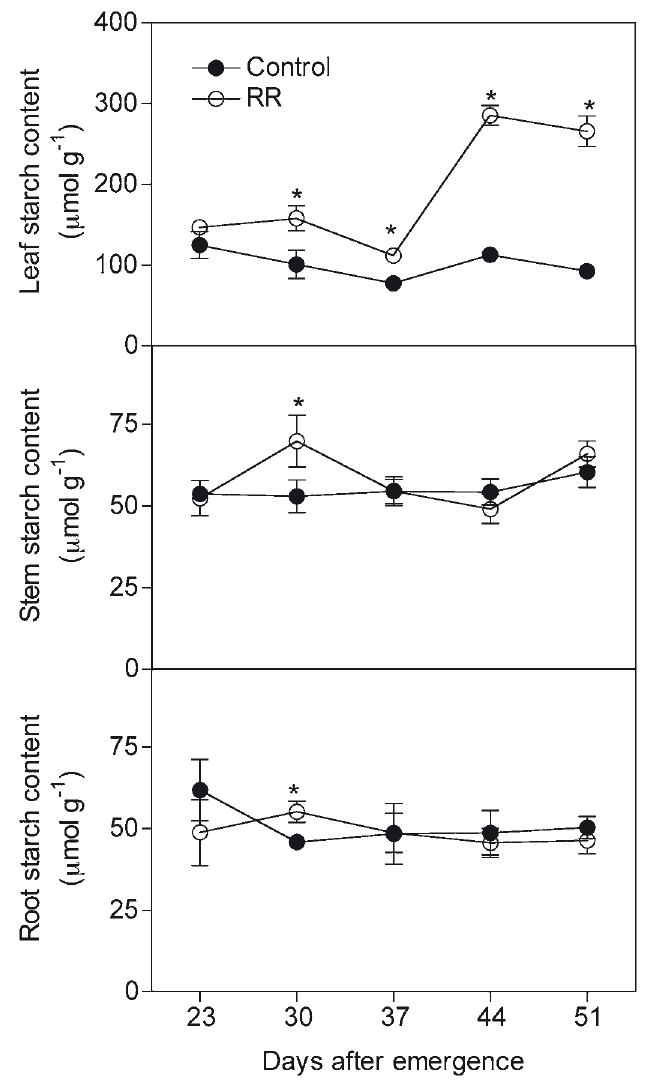
Fig. 6 - Starch content in the different plant organs measured at weekly intervals from day 23 to the end of the experiment in both con- trol and root-restricted (RR) plants:leaf (A), stem (B) and roots (C). * indicates significantly different values for P≤0.05 (n=5), when means were separated by Duncan’s